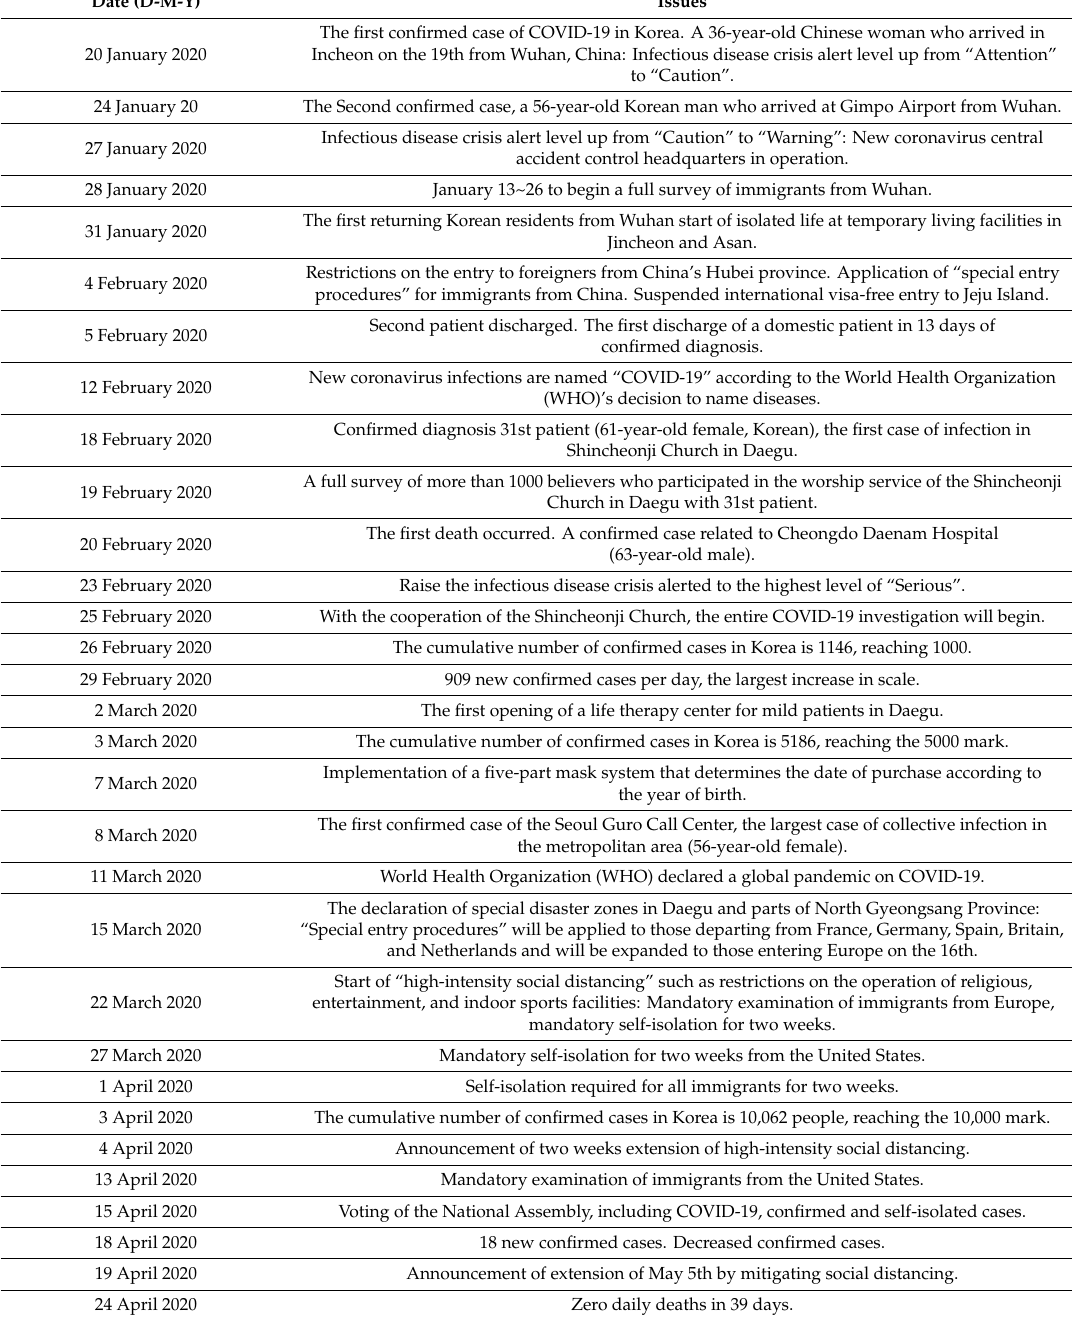
Table 1. COVID-19-related issues in